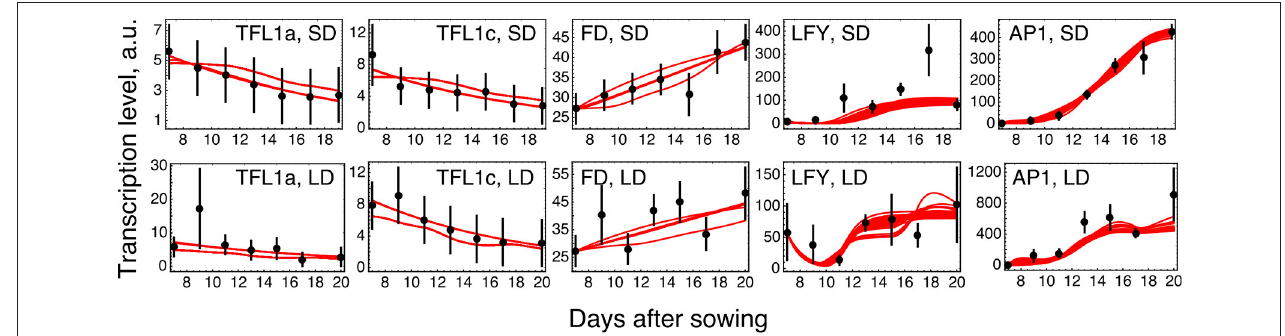
FIGURE 2 | Model H0 solutions for ICCV 96029 under two growing conditions. The model solutions (red curves) corresponding to all parameter sets found by optimization are shown for five flowering time genes and for the short day (SD, upper panels) and long day (LD, lower panels) conditions. The black dots and error ranges are the mean expression data and standard deviation, respectively, taken from (Ridge et al., 2017).